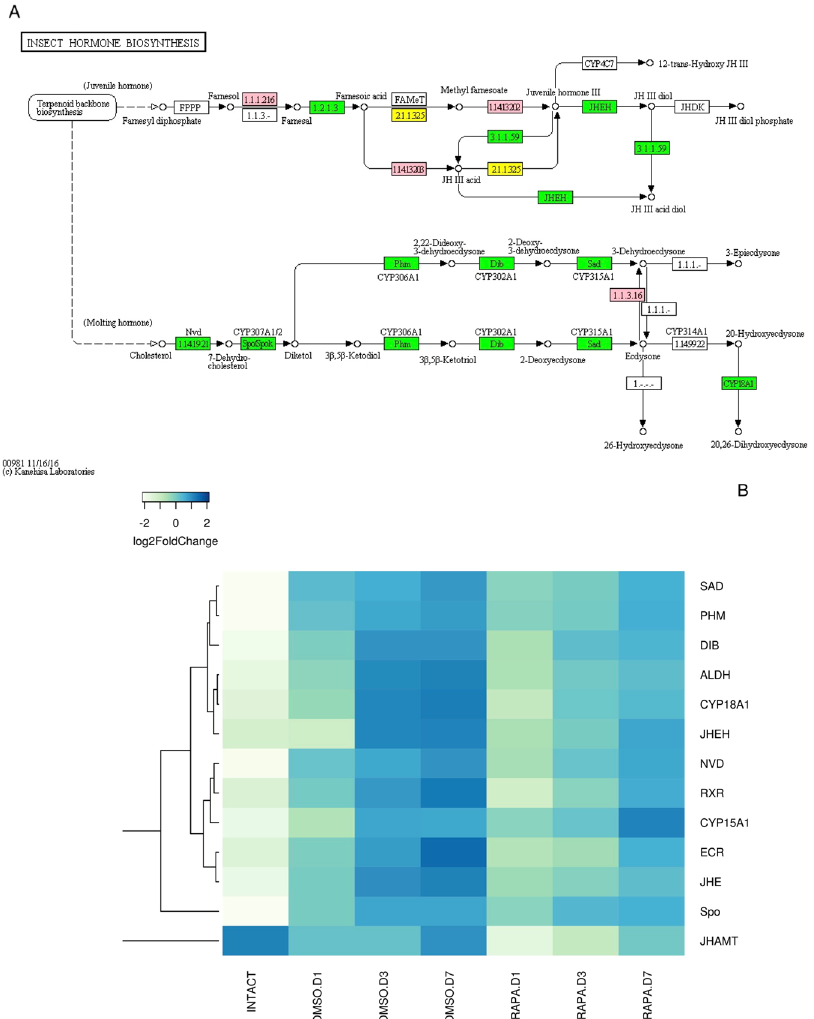
Figure 7. Identification of genes assigned to the insect hormone biosynthetic (IHB) pathway in the G . lateralis YO/I/DRESA transcriptome. KAAS was used to identify genes annotated by BLAST against the specific insect database (Section 4.5) and assigned to a KEGG pathway 38–40 . ( A ) IHB pathway components/genes. Colored boxes indicate the presence of the genes identified in the ESA database. A pink colored box signifies the presence of an annotated gene that does not show a change in expression levels; a green box indicates a significant increase in premolt transcript abundance relative to intermolt while a yellow box indicates a decrease in transcript abundance. ( B ) Heat map showing the log2-fold change of the FPKM values of the